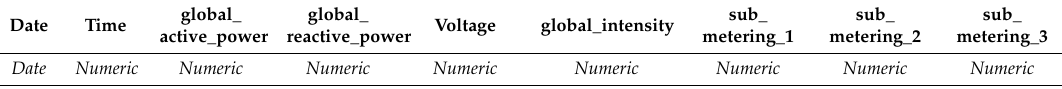
Table 6. Attributes with data type.